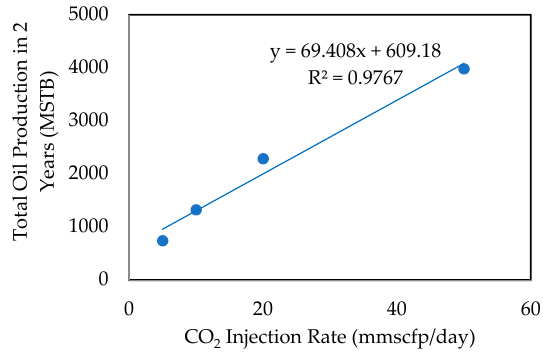
Figure 10. Variation of oil production with CO 2 injection rate (WAG).